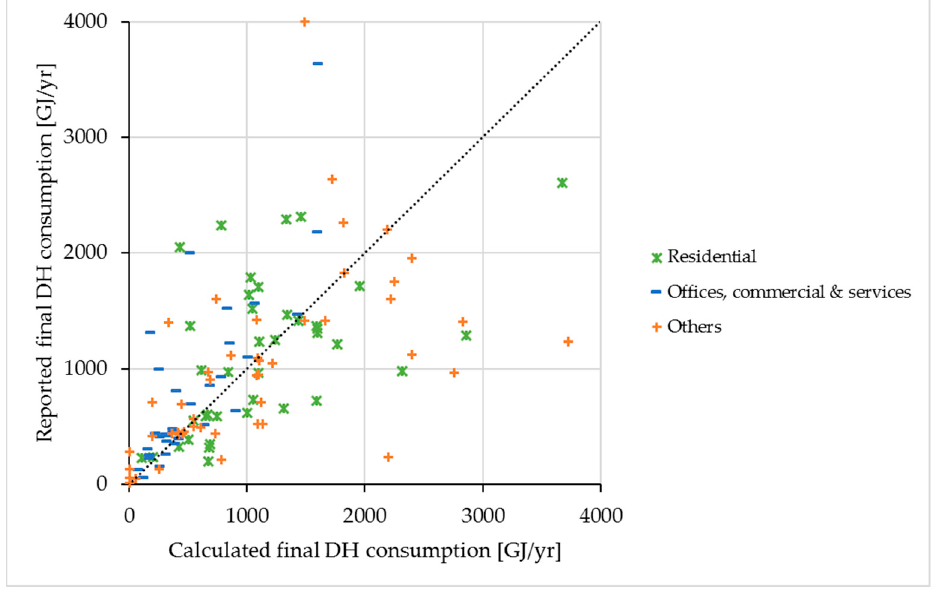
Figure 10. Comparison of the calculated and reported final district heat consumption.